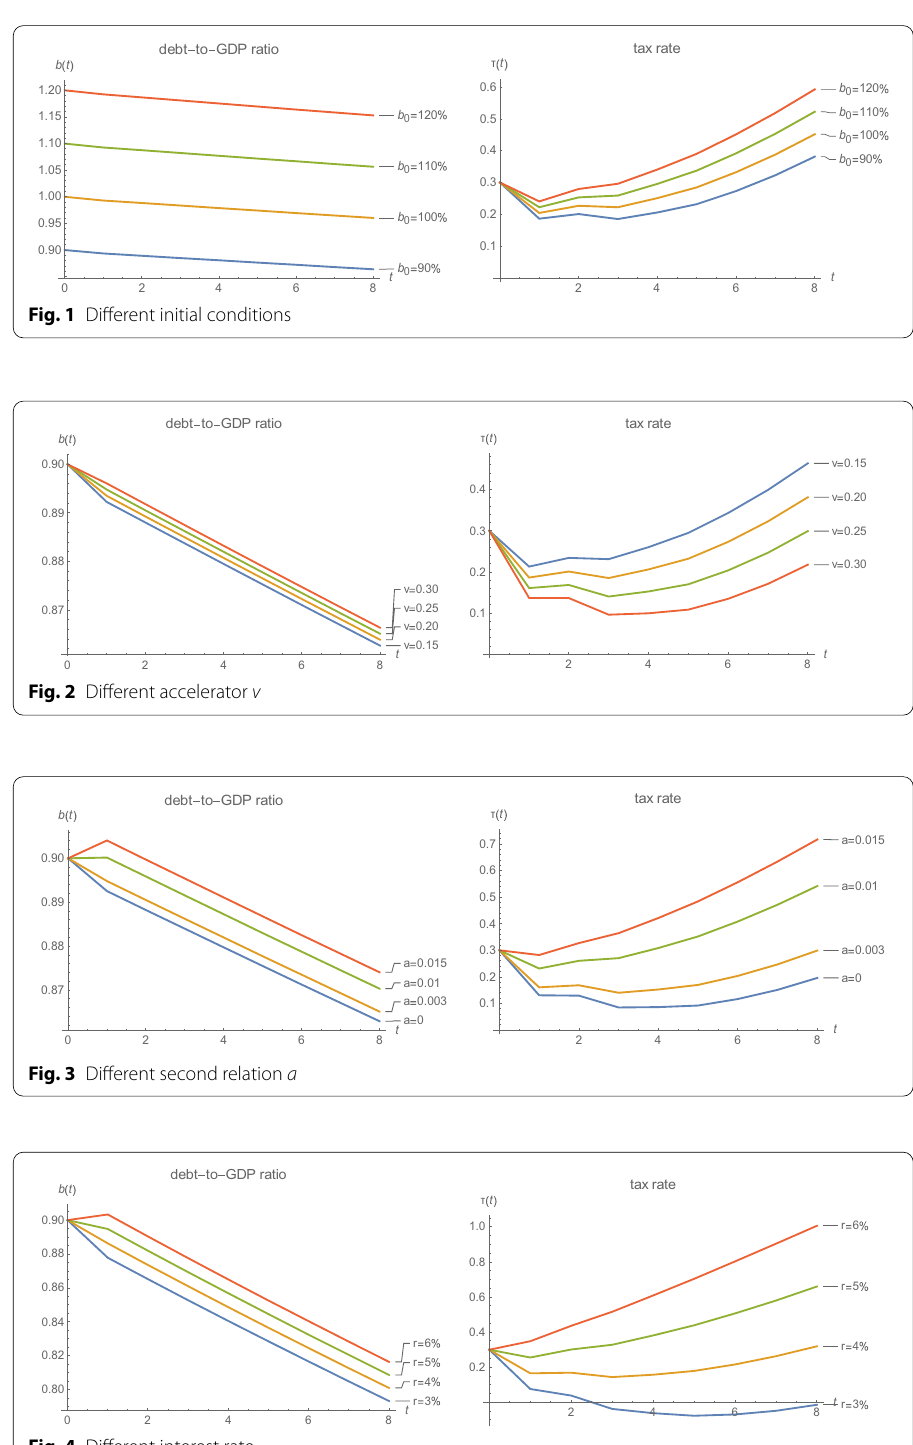
Fig. 4 Different interest